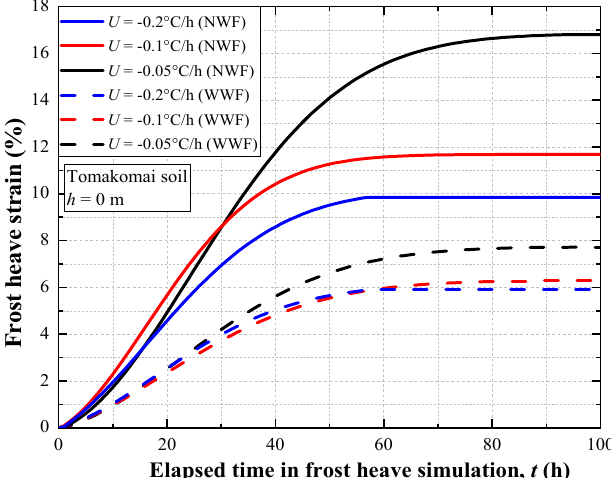
Figure 14. Effect of cooling rate on frost heave and WF inhibiting effect.